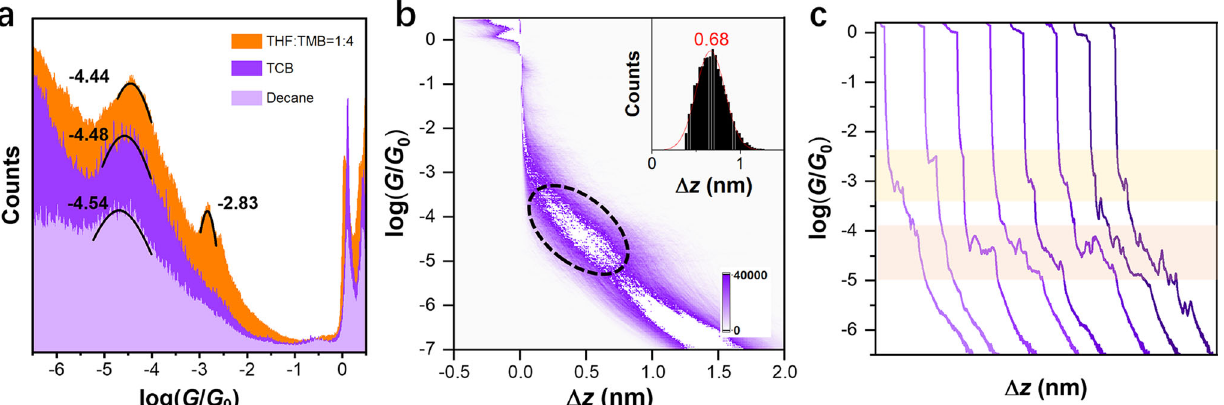
Fig. 4 The solvent effect on conductance measurement of o -PP-2SMe in the concentration of 0.2 mM. a One-dimensional conductance histograms of o- PP-2SMe in different solvents along with the values of the conductance peaks labeled beside the fi tting curves. b Two-dimensional conductance – displacement histogram of o -PP-2SMe in TCB with black dashed circle labeling the density cloud of LC state. Inset: relative displacement distribution. c Typical individual traces of o -PP-2SMe in TCB. The yellow frame corresponds to the plateau of HC states, while the orange frame corresponds to the plateau of LC states.